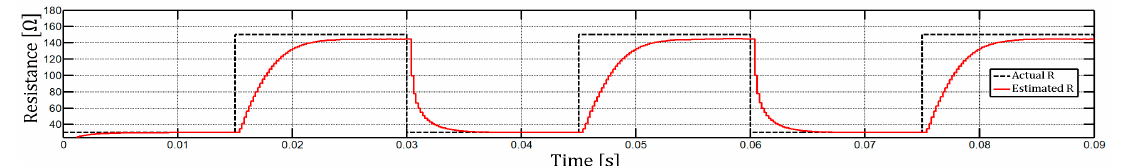
Figure 13. Simulation results to show the comparison of both controller when considering 𝑅 variations, 𝑅 = (cid:4670)20,50(cid:4671) Ω .